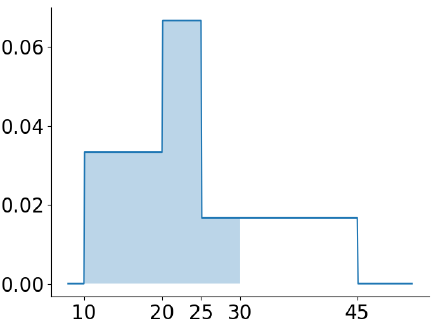
Figure 2. Restriction selectivity estimation of R 1. X <